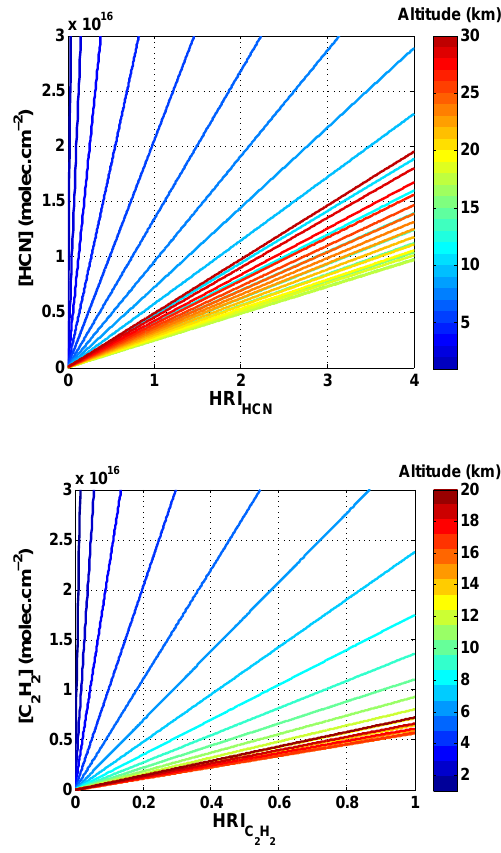
Figure 12. (Top) Simulated spectra in the region of the HCN ν 2 band and C 2 H 2 ν 5 band. The green (brown) double sided arrow gives the spectral range used to compute the S (cid:15) matrices for HCN (C 2 H 2 ). (Middle) Contributions of climatological background lev- els of HCN and C 2 H 2 . (Bottom) Contribution of CO 2 (red line), O 3 (green line) and H 2 O (blue line) to a simulated spectrum for background concentrations. Calculations have been made for the Figure 2. Variations of the HRI with HCN (top) and C 2 H 2 (bottom) US Standard Atmosphere (US Government Printing Office, 1976) Figure 13. Variations of the HRI with HCN (top) and C 2 H 2 (bot- column (moleccm − 2 ) integrated over the 1km thick polluted layer with CO 2 concentrations scaled to 390 ppmv. tom) column (molec.cm − 2 ) integrated over the 1 km-thick polluted in a standard modelled subtropical atmosphere from forward model layer in a standard modeled subtropical atmosphere from forward simulations. The colour scale gives the altitude of the polluted layer. model simulations. The colorscale gives the altitude of the polluted layer.